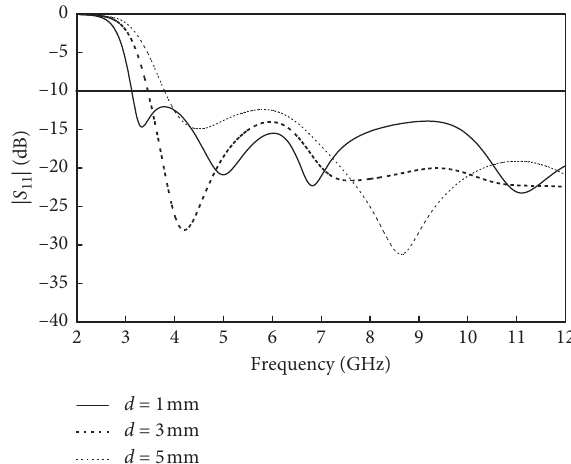
Figure 3: Simulated | S 11 | under variable a of 11, 12, 13, 14, and 15mm, given the other parameters remaining constant.